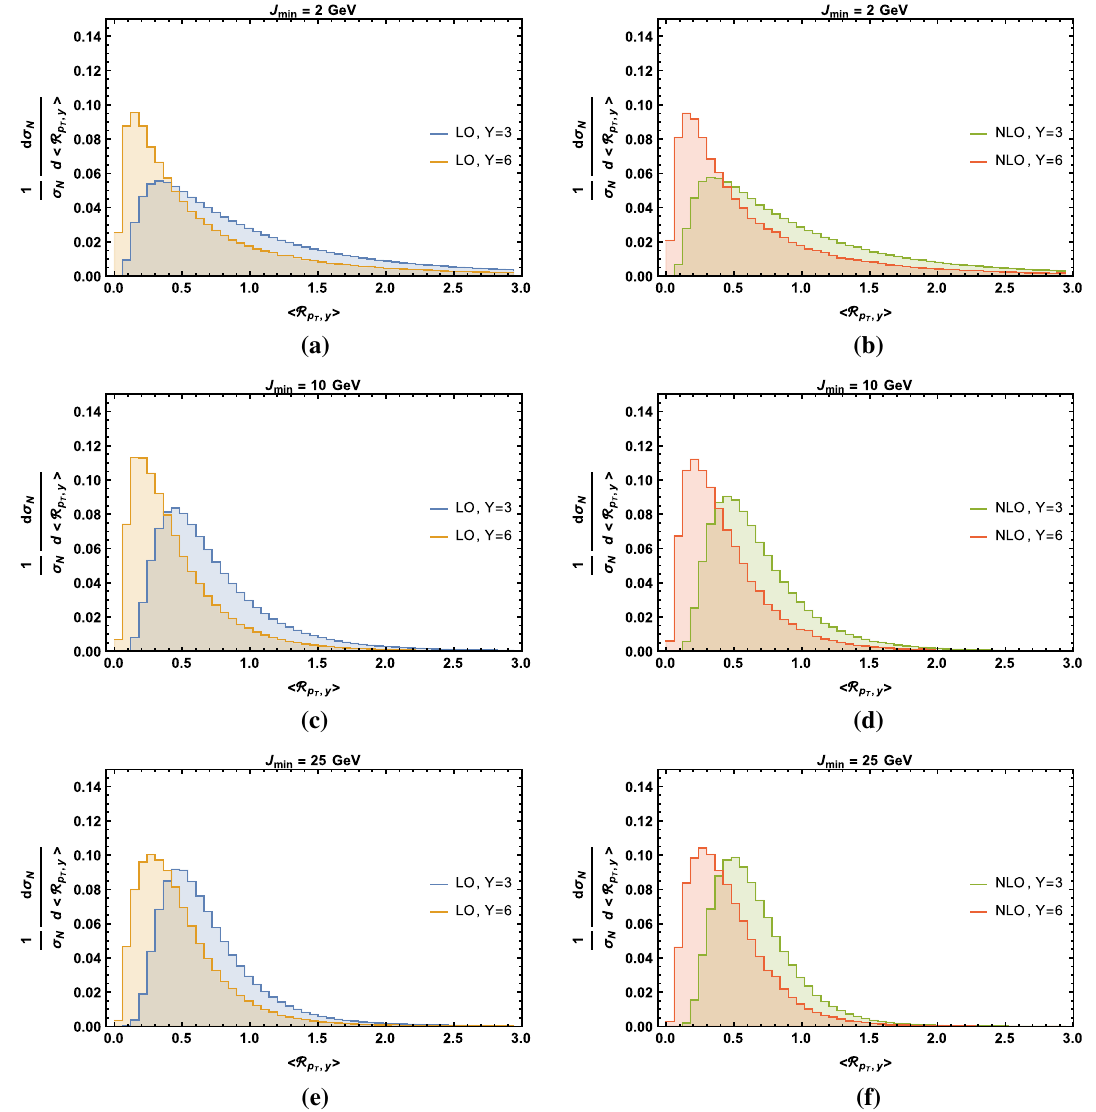
(cid:11) at LO (left) and NLO+DLs (right) for multiplicity N = 3, rapidity difference Y = 3 , 6 and J T , y